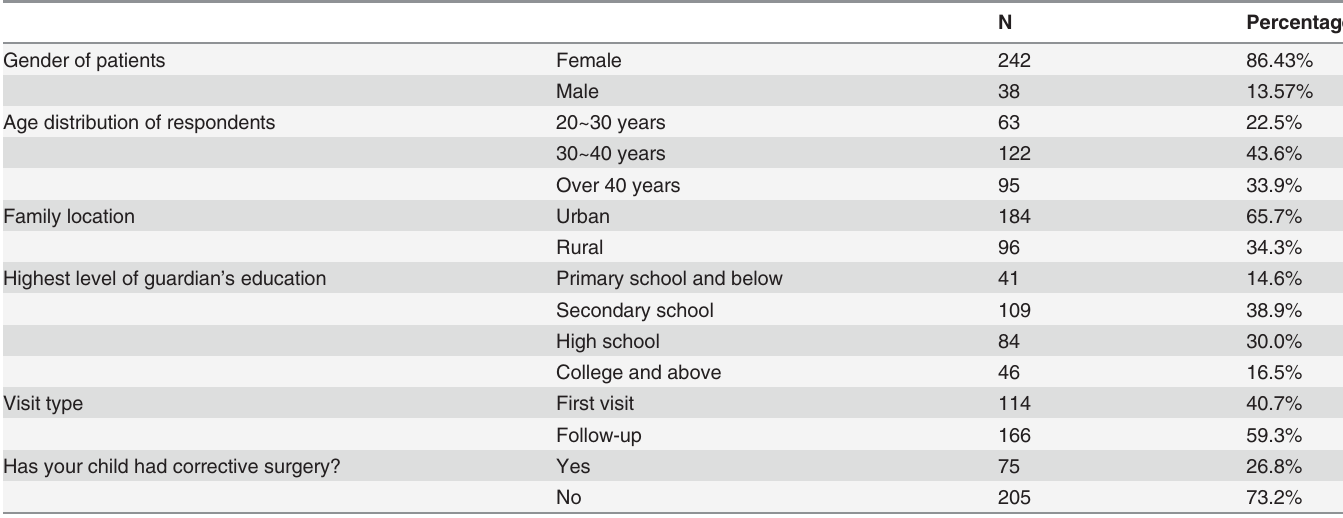
Table 1. Demographic details of the responses for the questionnaire.